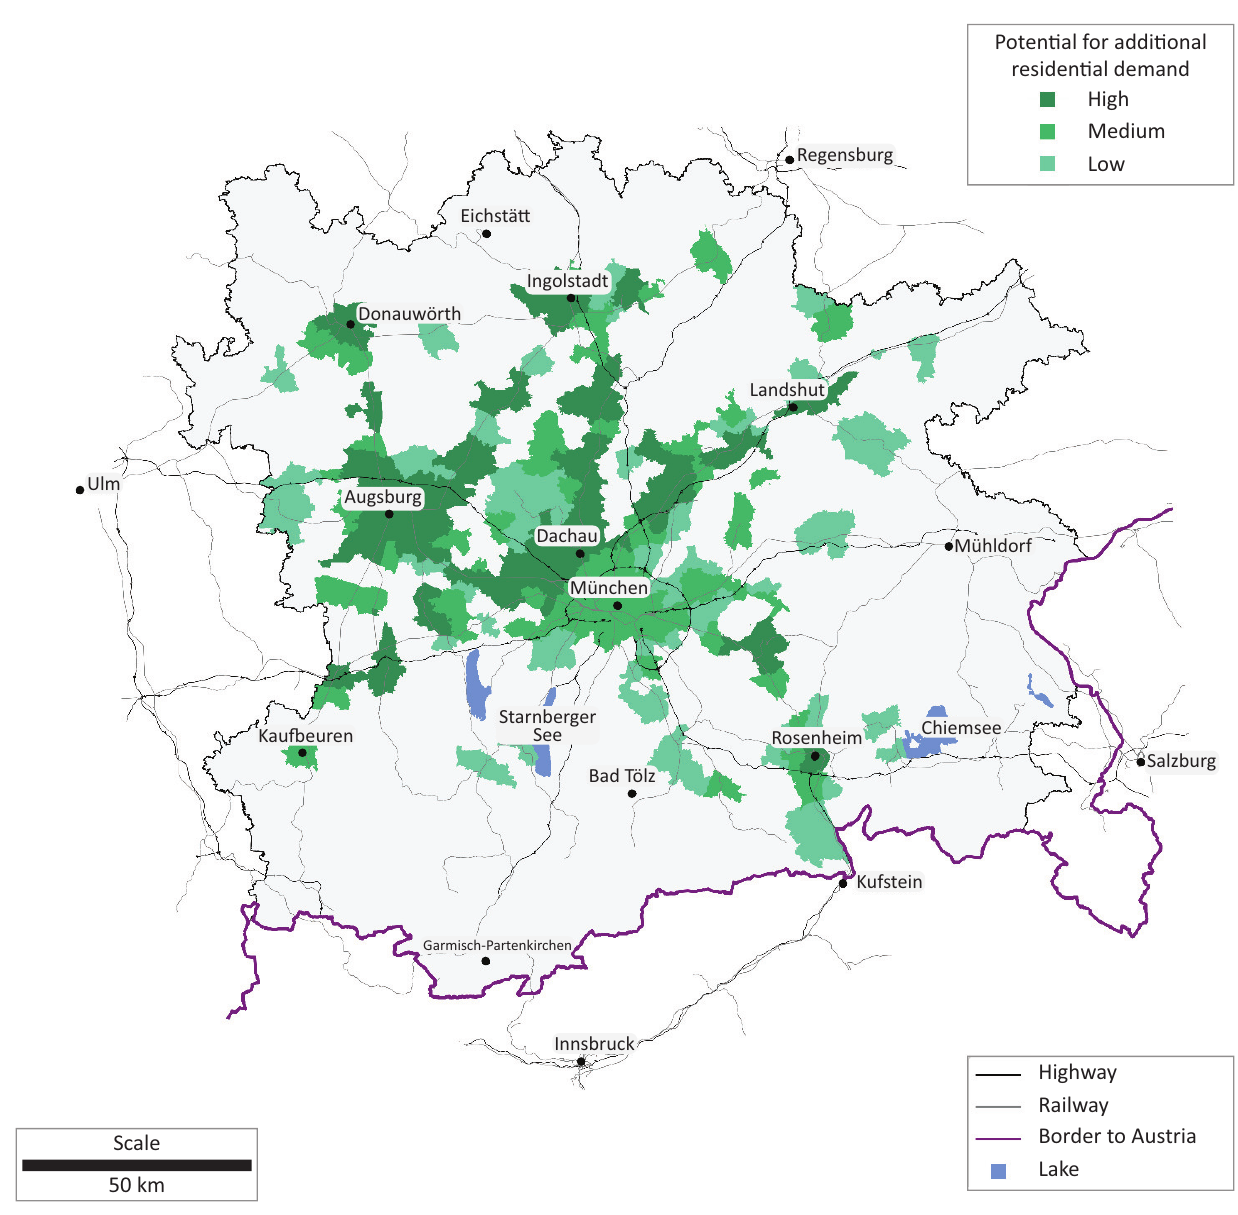
Figure 3. Municipalities with potential additional demand for residential space in the